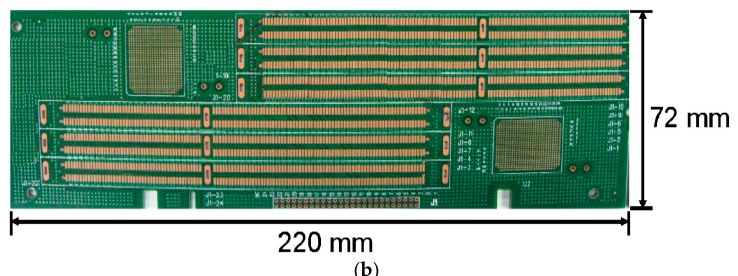
Figure 1. Configurations of ( a ) the printed circuit board (PCB) with dual in-line memory module (DIMM) sockets (called a PCB assembly), in which ( b ) the bare PCB is with the size of 220 × 72 × 2.5 mm.